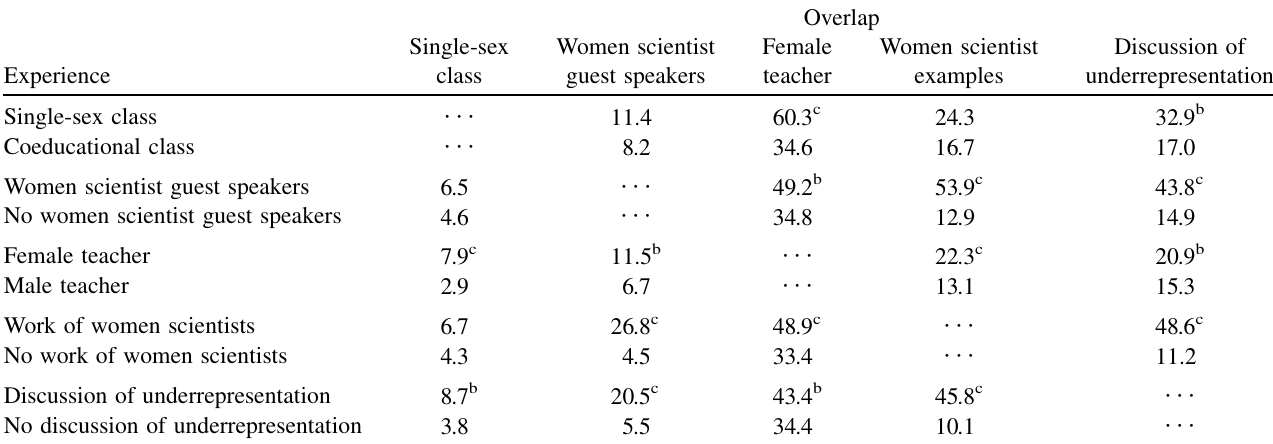
TABLE III. Percentage overlap in experiencing the conditions with pairwise chi-squared tests to denote significance (note that this is only for female students). For example, among female students who reported experiencing women scientist guest speakers, 6.5% had single-sex physics